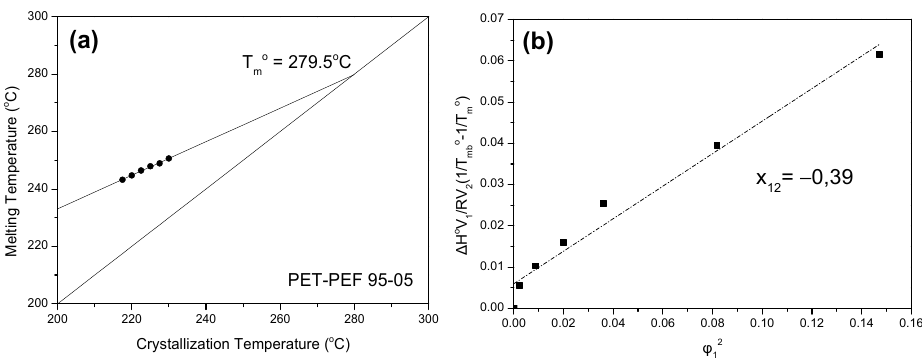
Figure 6. ( a ) Hoffman-Weeks plot for the determination of the equilibrium meting temperature of PET within the PET-PEF 95-05 blend, ( b ) Plots of against φ 2 using equilibrium melting temperatures.